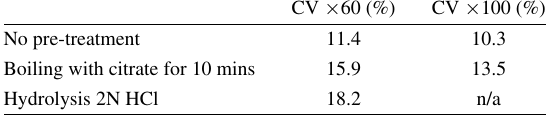
Comparison of coefficients of variations (CVs) of DNA histograms obtained with confocal laser scanning microscopy based 3D DNA cytometry in normal adrenal tissue stained with TO-PRO-3 iodide and treated with RNase for 0, 1 or 18 hours Duration of RNase treatment (hr)